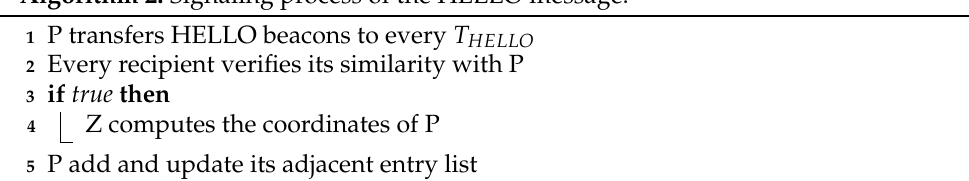
Algorithm 2: Signaling process of the HELLO